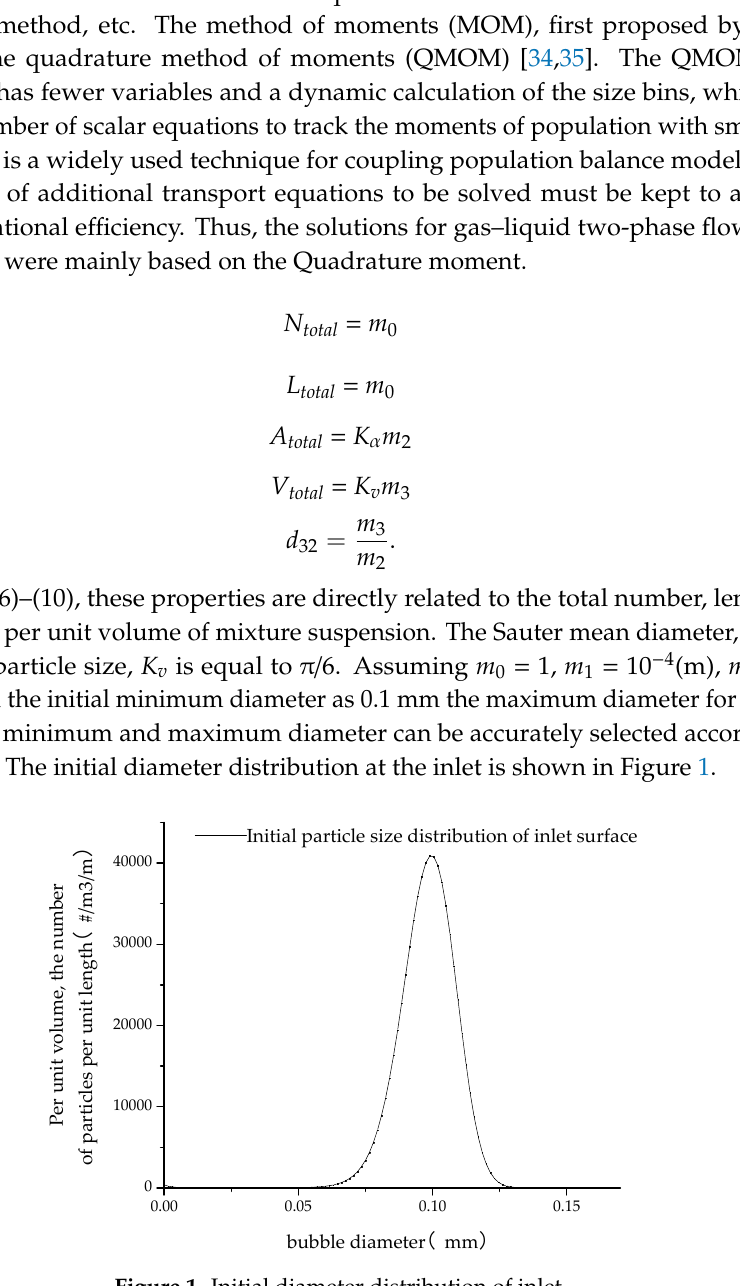
Figure 1. Initial diameter distribution of inlet.